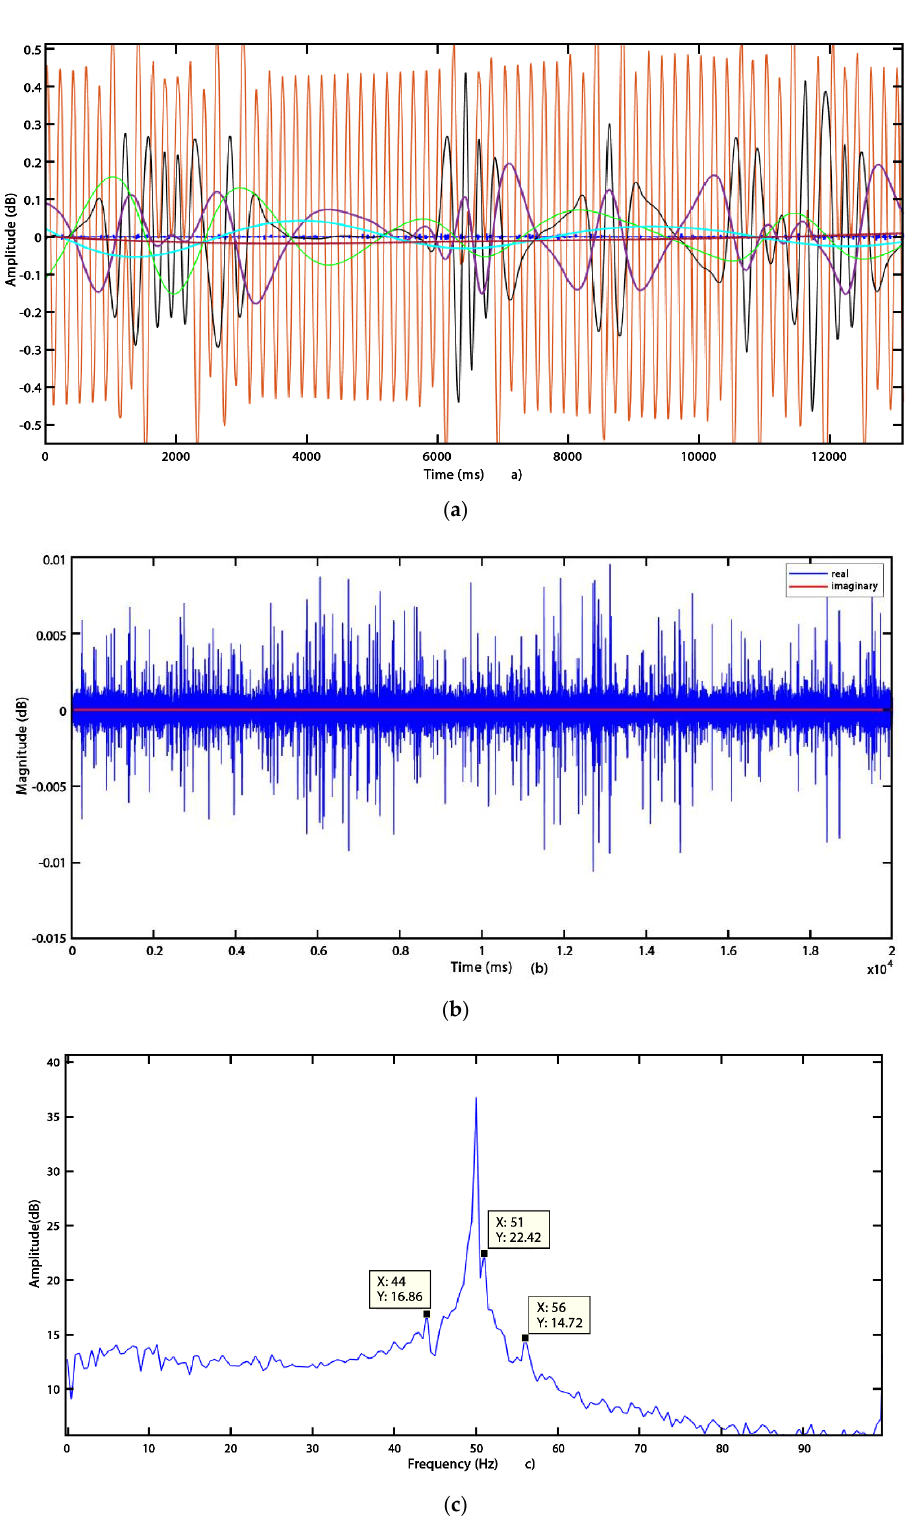
Figure 8. ( a ) Signal IMF, ( b ) HHT for the 1st IMF, ( c ) FFT of the 1st IMFs.